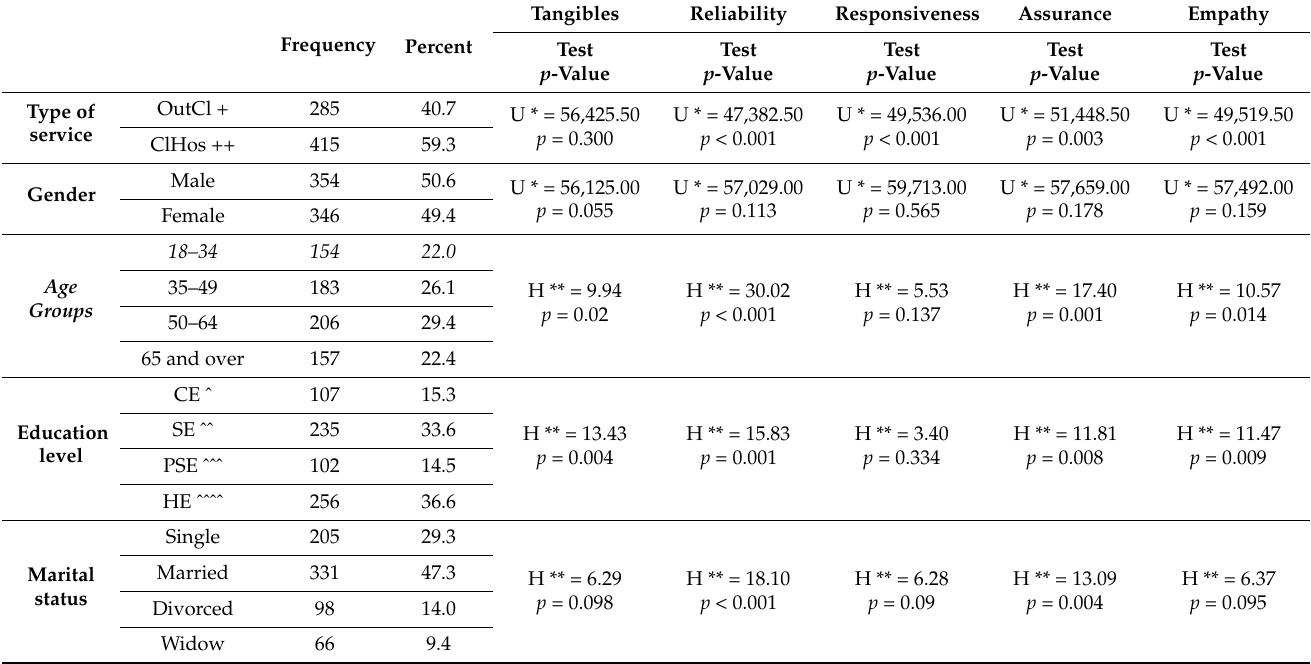
Table 2. Demographic characteristics of the respondents ( n = 700) and evaluation of the impact of demographic characteris- tics on SERQUAL